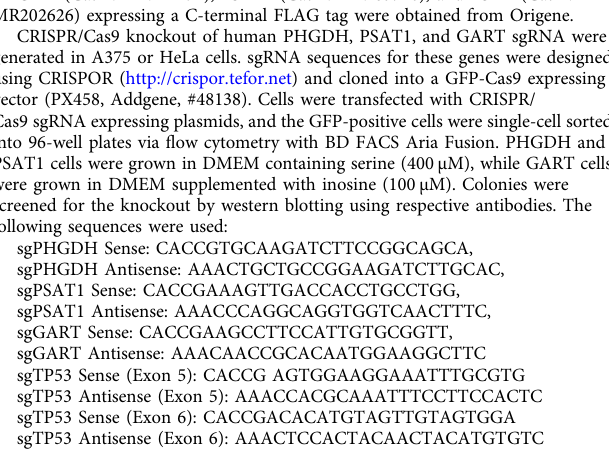
Fig. 4 Purine depletion-induced cell migration is dependent on serine synthesis and one-carbon metabolism. a Quanti fi cation of the migrated distance (Wound-healing assay, 24 h) of A375 cells after MTX treatment (100 nM) in the presence or absence of PHGDH inhibitors (BI-4924, 15 µ M and